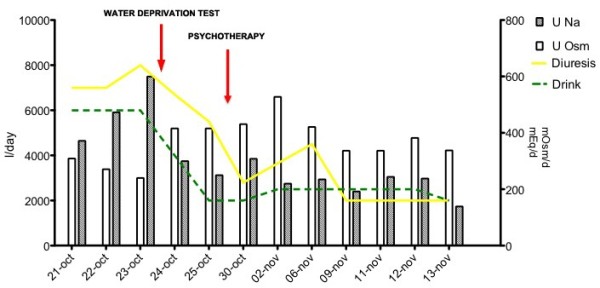
Time trend of clinical and laboratory parameters during the hospitalization. Before the water deprivation test the patient declared a daily water intake of about 1 L, but after the beginning of psychotherapy he admitted to have ingested about 6 L of liquids per day. Abbreviations are: Uosm = urinary osmolarity, UNa = urinary sodium.